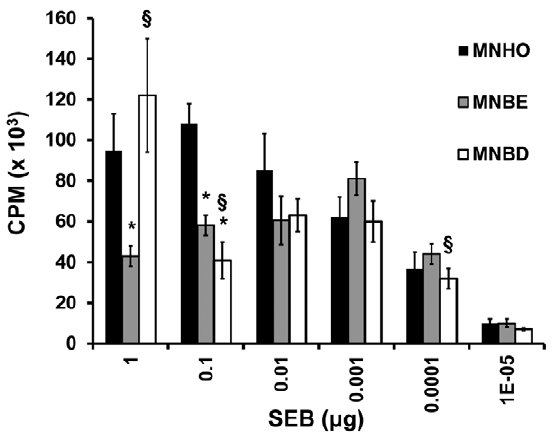
Figure 3. Variant SEBs differ in their ability to cause proliferation of rabbit splenocytes. Rabbit splenocytes were exposed to varying concentrations of SEB from strains MNBE, MNBD, or MNHO, and subsequently incubated with 3 H-thymidine. Cellular proliferation is reported as the measure of the counts per minute of 3 H- thymidine that had incorporated into the DNA of the splenocytes. The mitogenicity of each toxin was measured in quadruplicate. The three toxins caused different patterns of splenocyte proliferation. Error bars represent the standard deviations, and statistical significance was determined by using Student’s unpaired t -test. *, P , 0.05 with respect to MNHO. 1 , P , 0.05 with respect to MNBE.